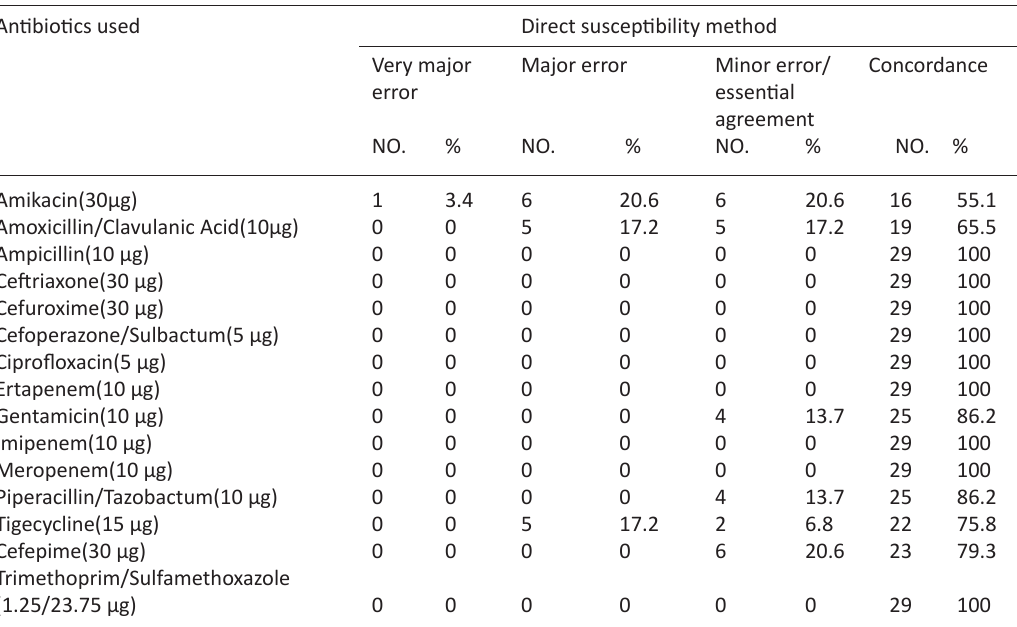
Table 4. Direct antibiotic susceptibility correlation for E.coli (n=29) Antibiotics